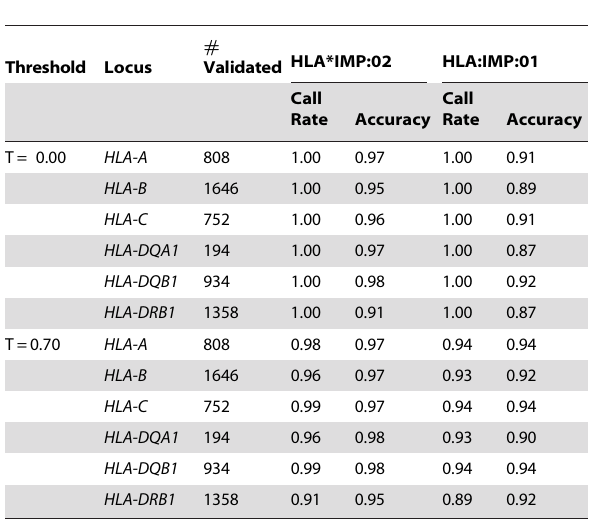
Table 3. Multi-population European validation results.